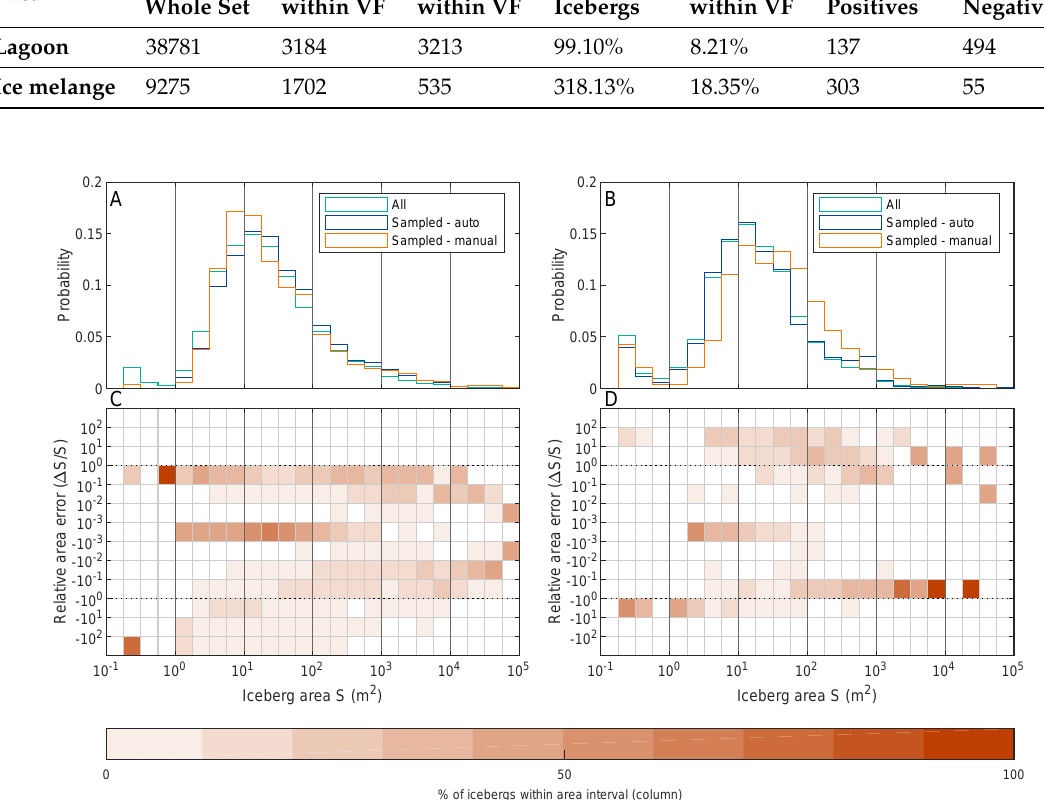
100 % of icebergs within area interval (column) Figure 10. Results of quality assessment of iceberg map: ( A , B ) histograms of frequency of iceberg areas; and ( C , D ) 2D histograms of unsigned relative error of manually digitized icebergs compared to automatically mapped ones. Plots ( A , C ) relate to the lagoon, while ( B , D ) to the fields of ice melange. Dashed lines show the lines of 100% relative error. Values within each column add up to S for 100%. Relative differences were computed as S man − S cla . X-axis divisions spaced by equal log 10 S man histogram